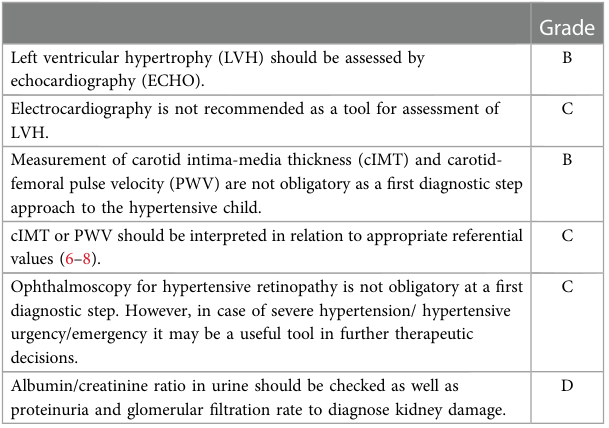
TABLE 5 Recommendation when and how to assess the presence of hypertension-mediated organ damage.